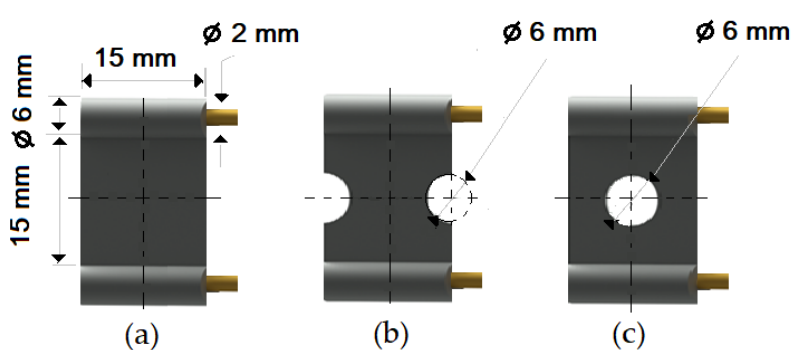
Figure 1. The geometry of studied samples: ( a ) basic configuration, ( b ) double side inhomogeneity, ( c ) central inhomogeneity. Table 1. Rubber